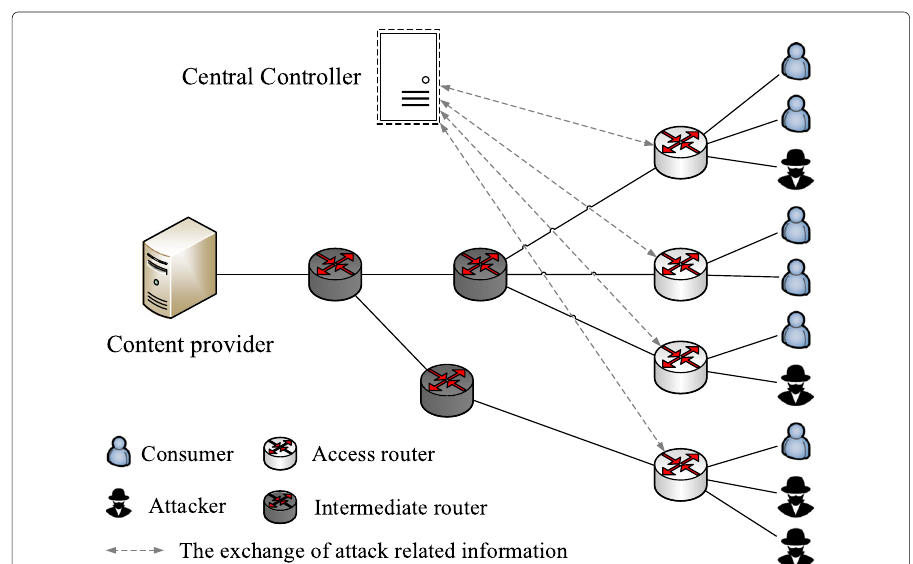
Fig. 1 The overall framework of